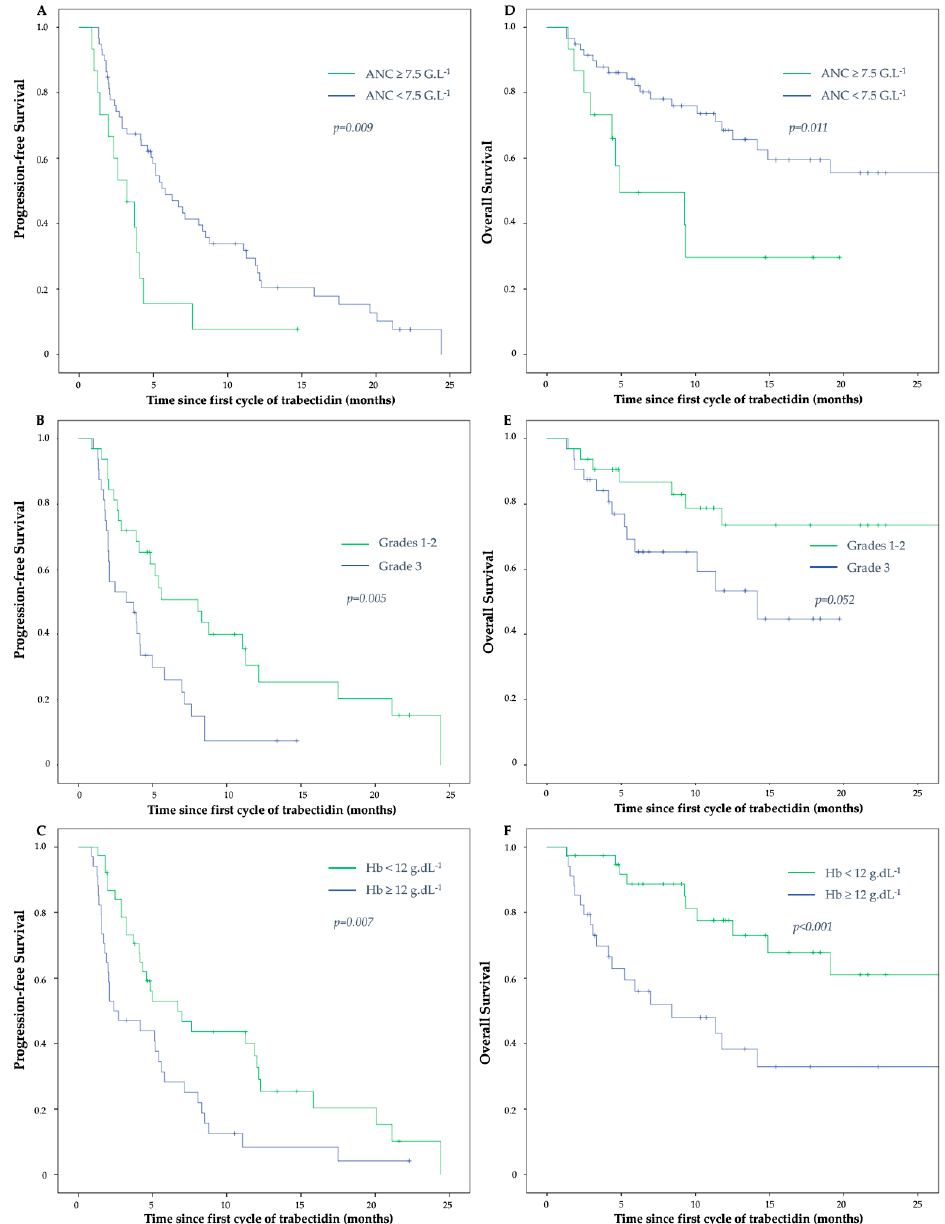
Figure 1. Kaplan-Meier estimates of progression-free survival (left panels) and overall survival (right panels), respectively, in patients with absolute neutrophil count (ANC) < or ≥ 7.5 G/L ( A , D ) patients with grade 1, 2, or 3 tumors ( B , E ) and patients with hemoglobin level (Hb) < or ≥ 12 g/L ( C , F ).